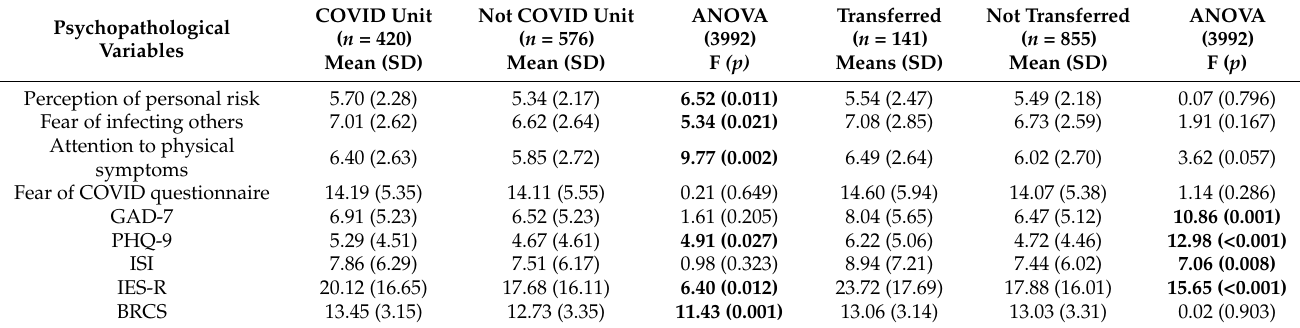
Table 4. Psychopathological scores in healthcare workers (HCWs) by unit and transfer to other units.